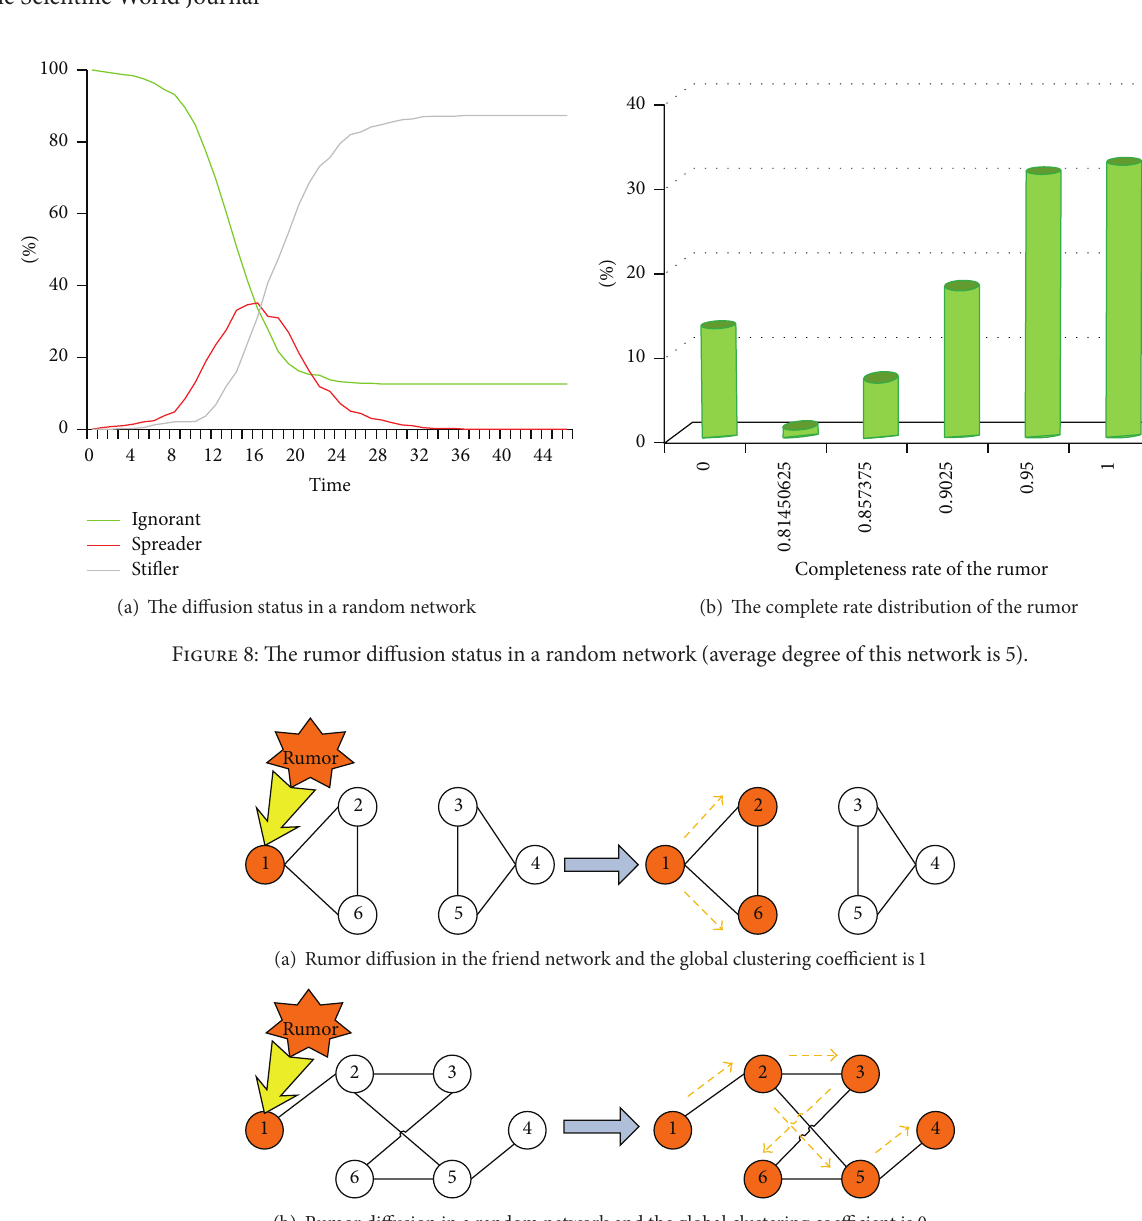
Figure 9: Rumor diffusion in a friend network and a random